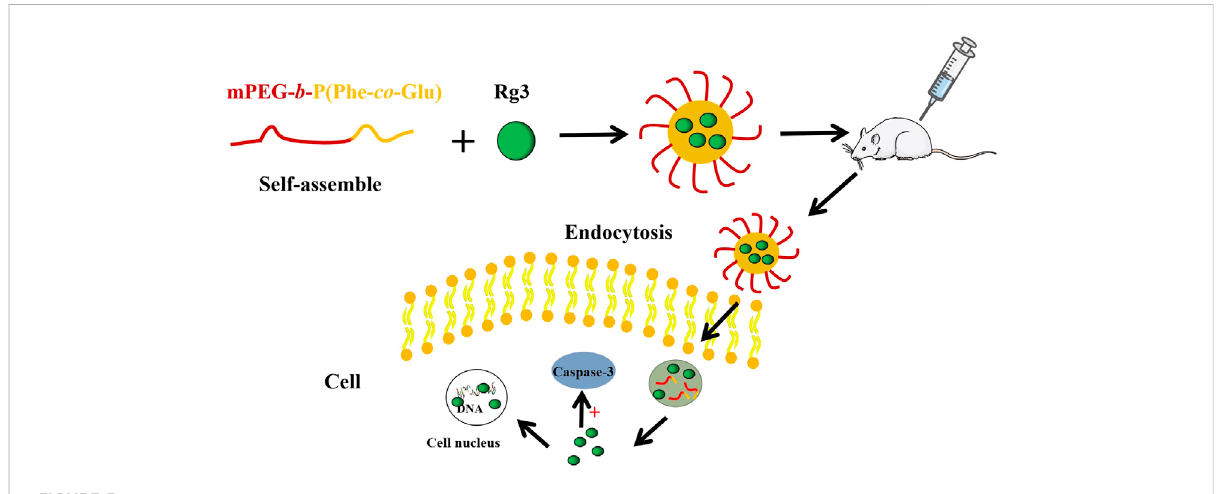
FIGURE 5 Preparation and action mechanism of